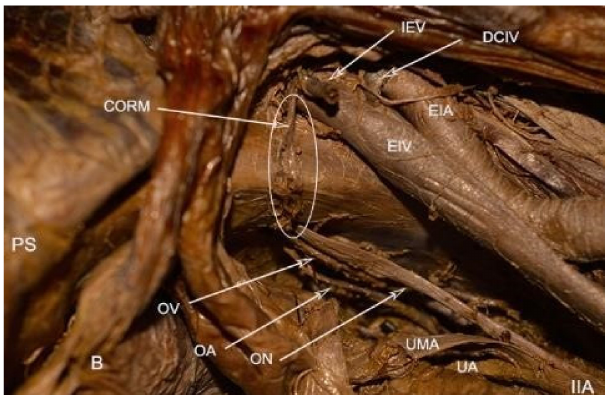
Figure 5. Corona mortis—embalmed cadaver (right side of the pelvis). Rare case of